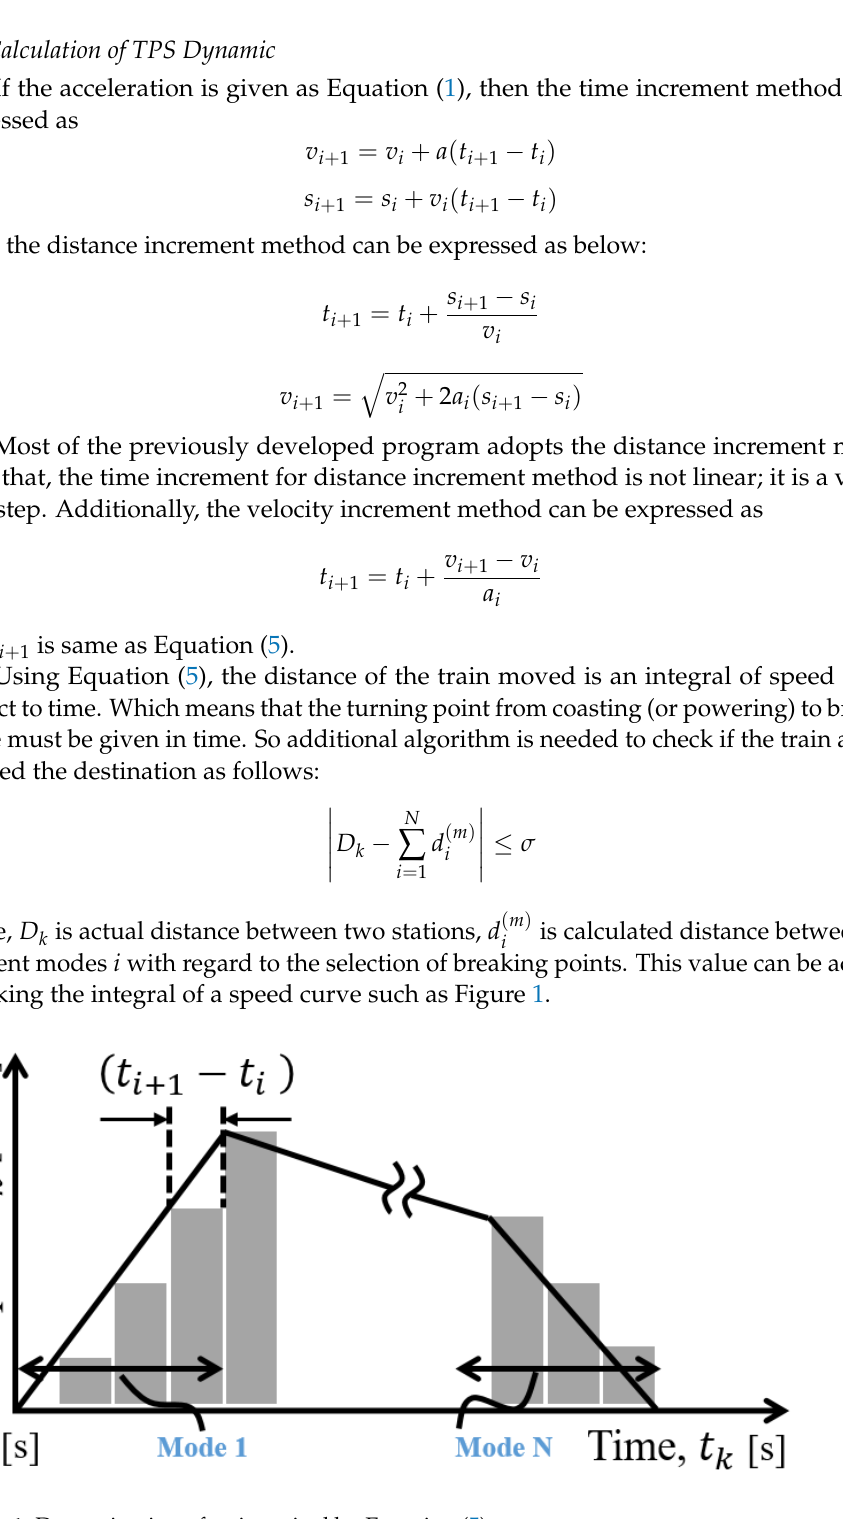
Figure 1. Determination of train arrival by Equation